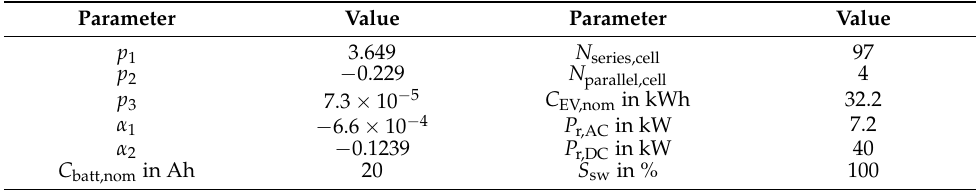
Figure 8. OCV of one cell for the applied battery model to different SOC states for the modeled reference device EV. Table 3. Parameters for the applied battery and EV model.